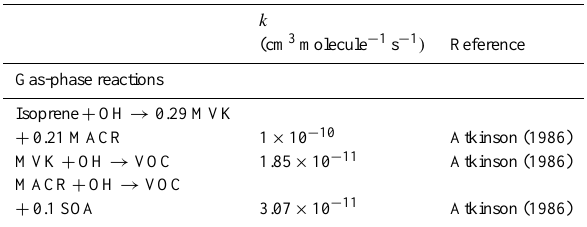
Table 3. Kinetic parameters for gas-phase reactions for the multi- phase simulations to compare aqSOA and gasSOA formation from isoprene (Fig.